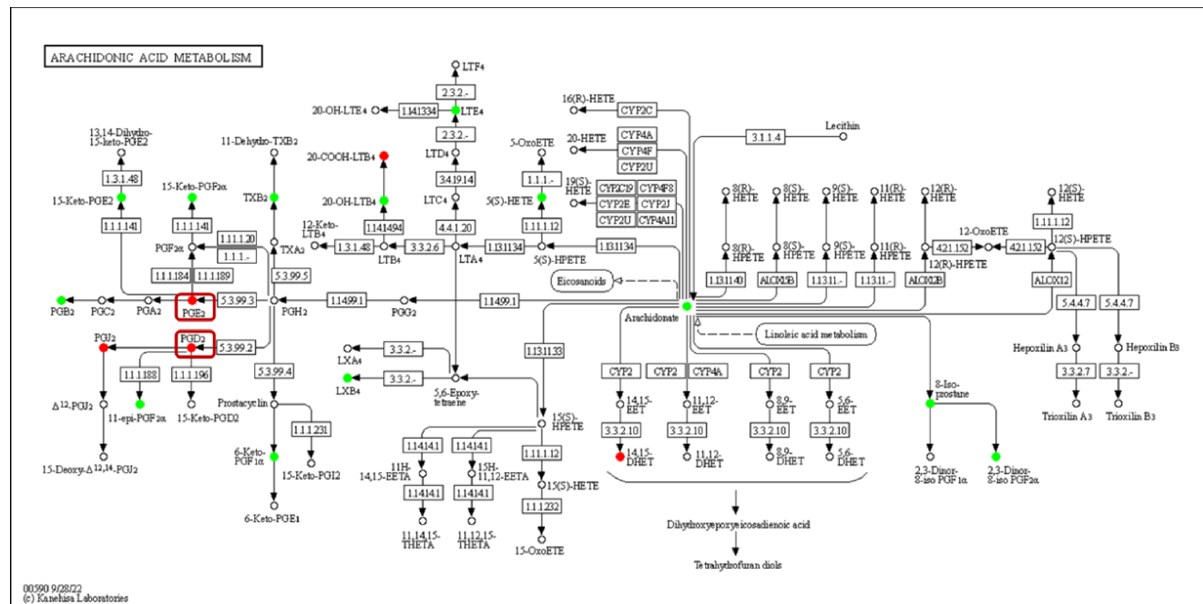
Figure 9. Enrichment of differentially oxidized lipid metabolites in the arachidonic acid metabolism pathway (ko00590). No differentially expressed genes were detected, and differential metabolites are circled, while boxes highlight the novel signaling molecule PGs.